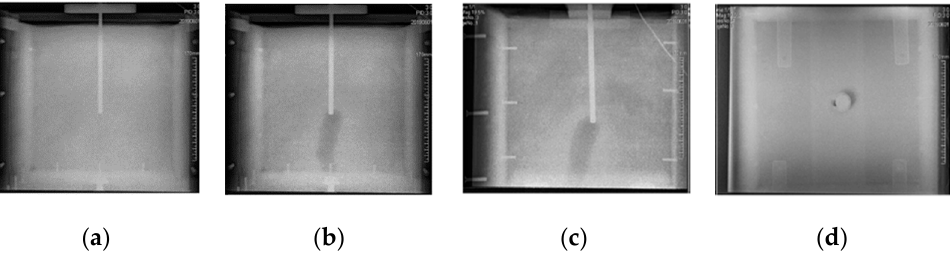
Figure 9. Images of modified soil with the SAP content of 0.1%: ( a ) Before breakdown; ( b ) front view; ( c ) side view; ( d ) top view.